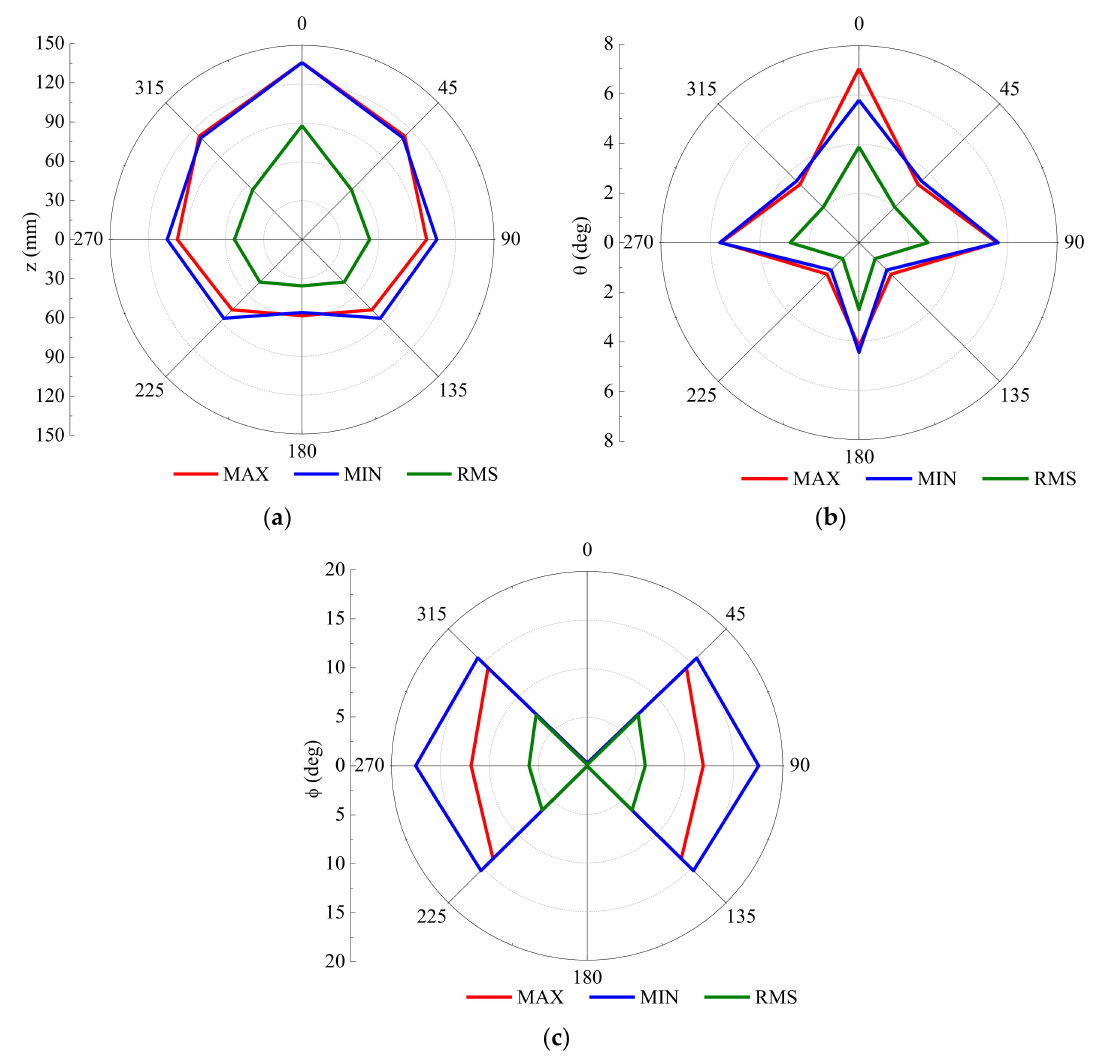
Figure 18. Response statistical values at di ff erent resultant wave heading: ( a ) heave; ( b ) pitch; ( c )